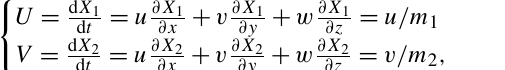
Table 9. Vertical mapping factors z ← X 3 for different coordinate systems, where h(x,y) is topography and H is the top of the com- putational